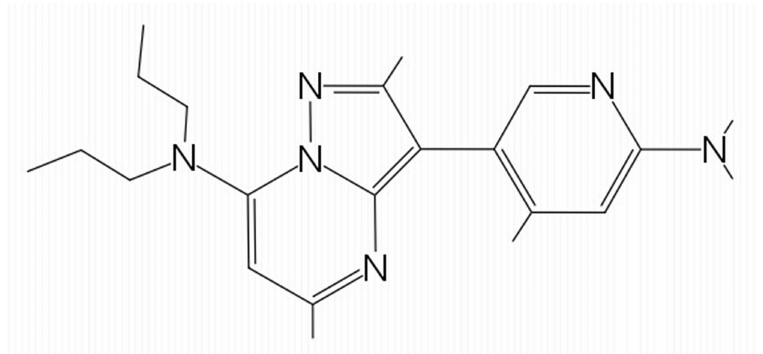
Fig 1. The chemical structure of CRFR1 antagonist